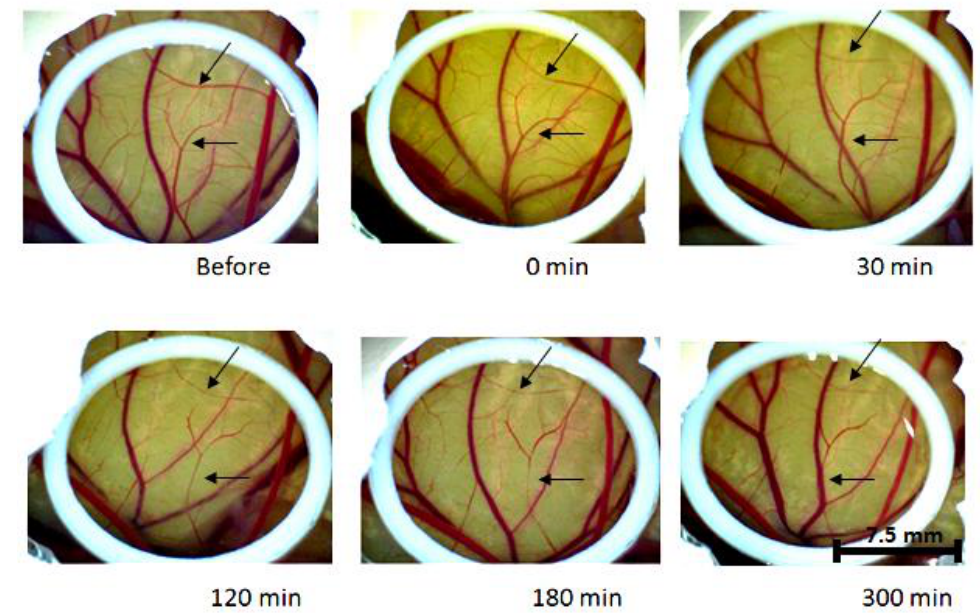
Figure 2. Only Curcumin (10 mM) effect over the time without light. The arrows point out vessels that became thinner over